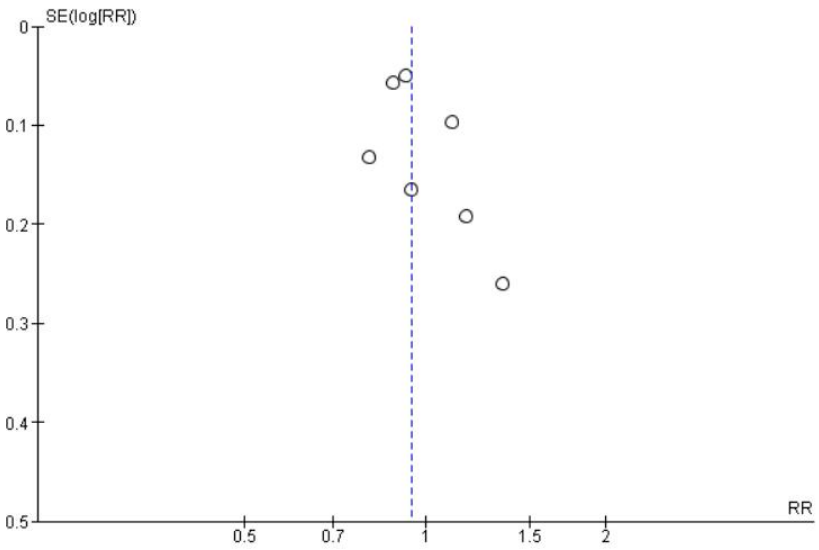
Figure 12. Funnel plot showing publication bias of studies on success rate in young immature permanent teeth undergoing regenerative endodontic procedure (REP) or apexification procedure.